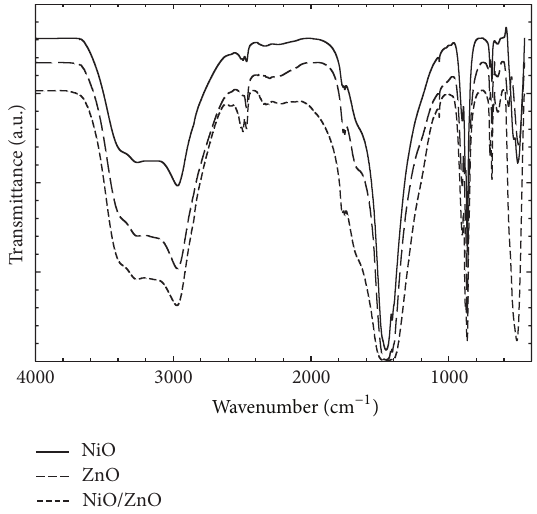
Figure 3: FTIR spectra of NiO nanoparticles, ZnO nanowhiskers, and NiO-ZnO